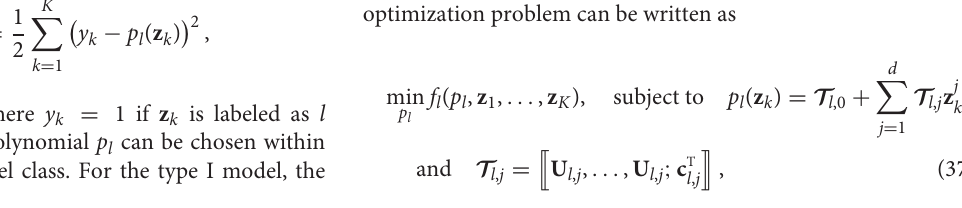
f l ( p l , z 1 , . . . , z K ) =